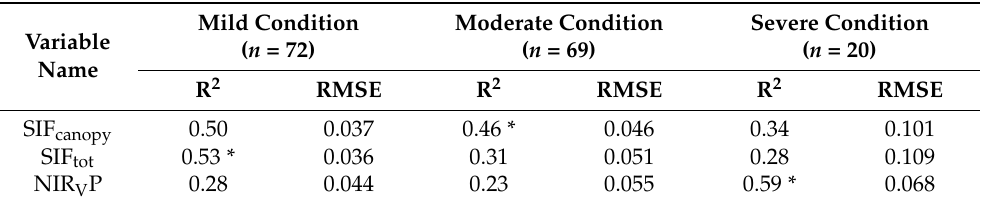
Table 1. Model accuracy test under different disease